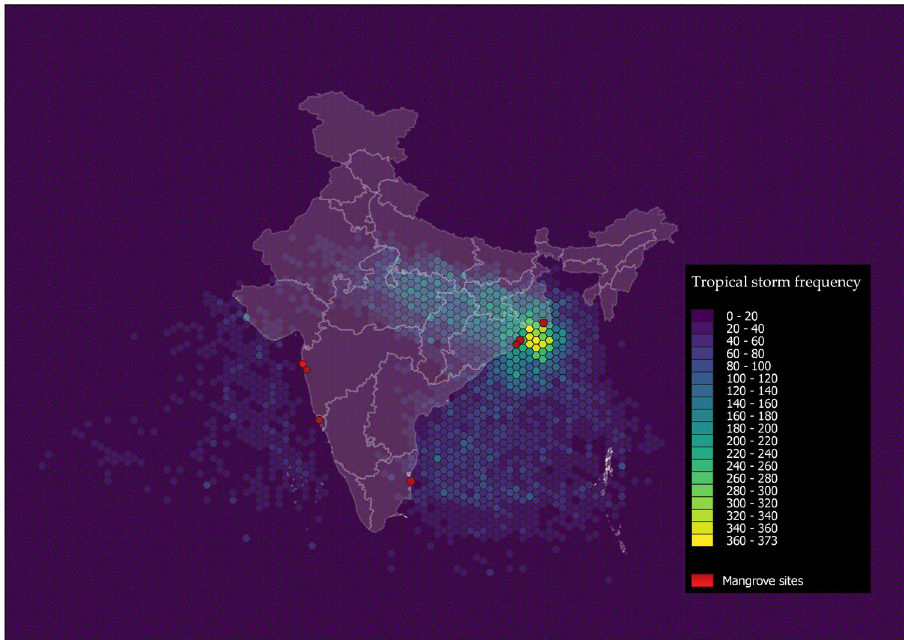
Figure 1. Cyclone frequency from 1890 to 2020 along the Indian coast. The numbers indicate the frequency of storms overlapping on a 0.5 by 0.5 deg hexagon grid. The darker purple shades represent low frequency, whereas green to yellow shades indicate higher frequency. Red circles show the location of mangrove forests explored in this